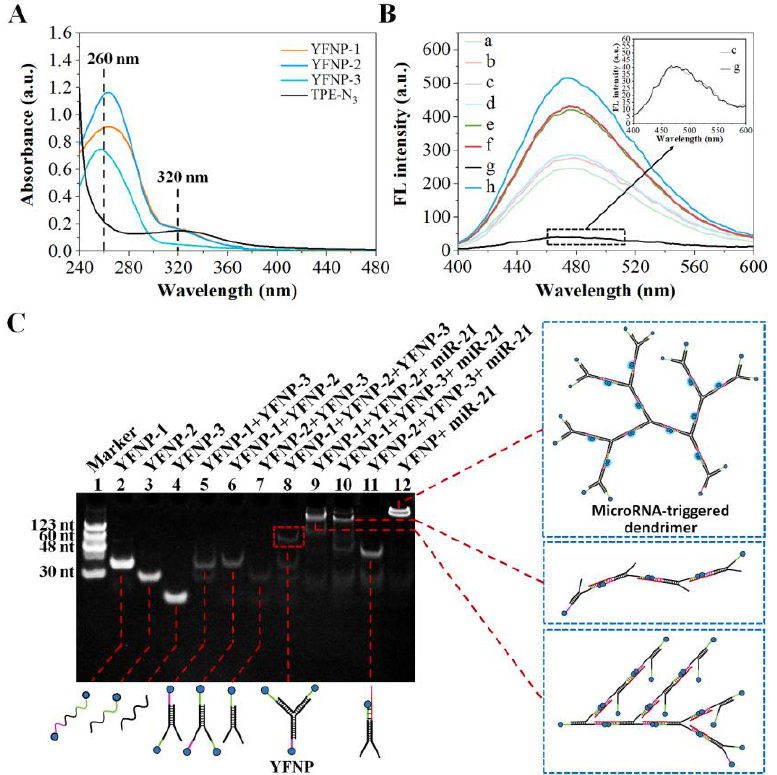
Figure 2. ( A ) UV-Vis absorption spectra of the YFNP-1, YFNP-2, YFNP-3 and TPE-N 3 . TPE-N 3